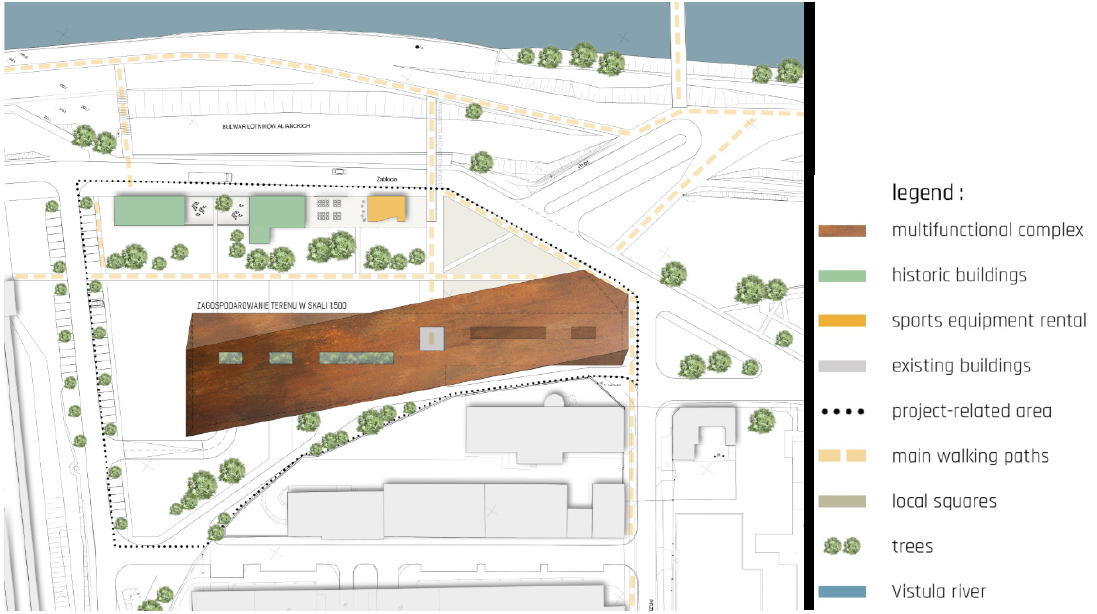
Figure 22. Designed land development, including the multifunctional complex and nearby objects, own elaboration (elaborated by E. Latusek).